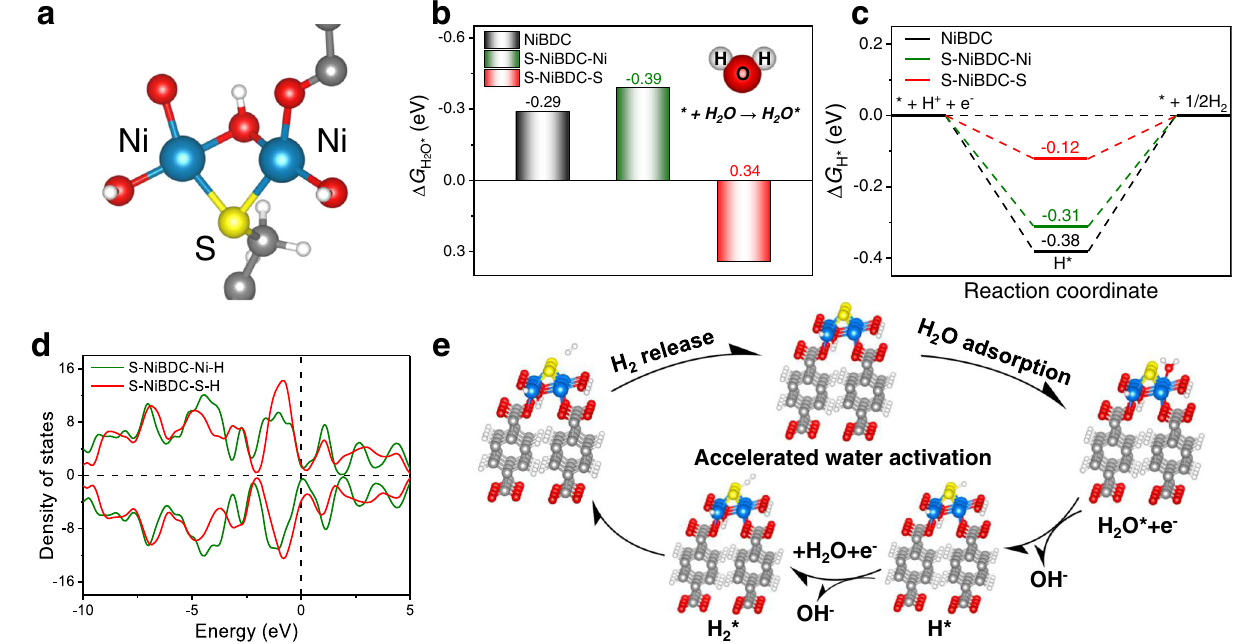
Fig.6|Theoreticalcalculations.a Modelof “ Ni 2 -S 1 ” activeregioninS-NiBDC.Free- energydiagramsfor b wateradsorptionand c HadsorptionofNiBDCandS-NiBDC. d PDOSofdifferentsitesforS-NiBDCwithHbinding. e